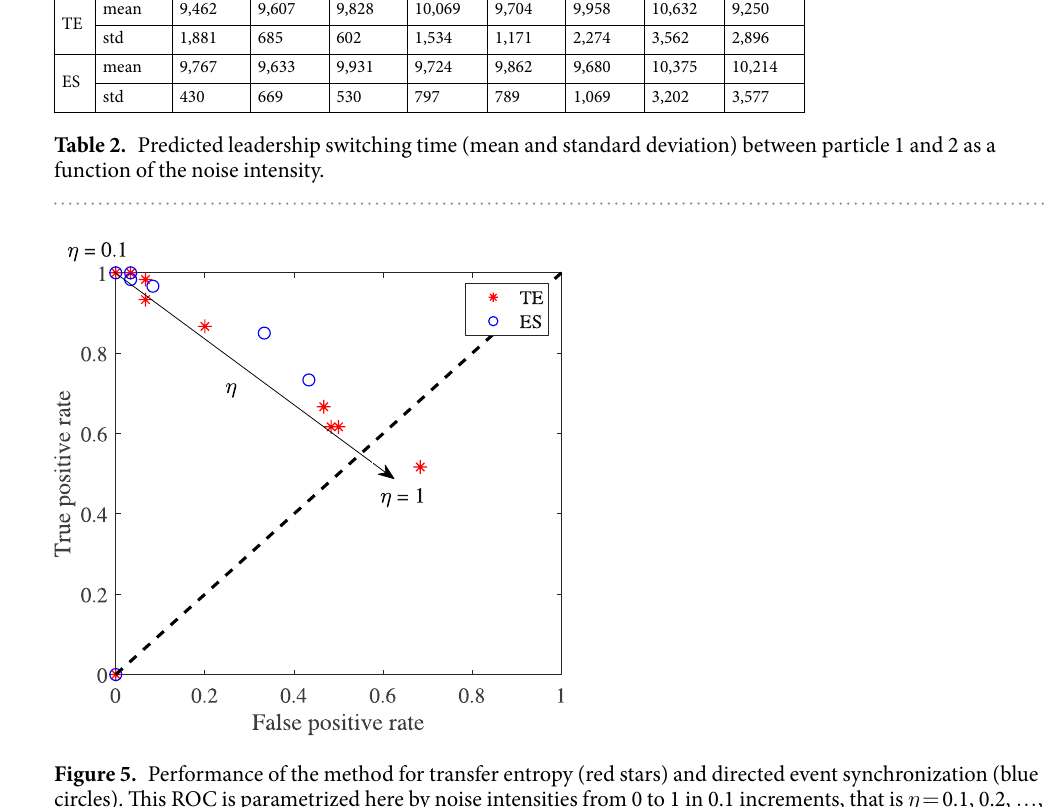
= . and = . A 0 0091 ). Note that the TE ES